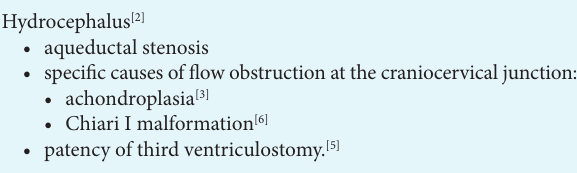
Table 1. Indications for performing CSF flow studies in children Hydrocephalus